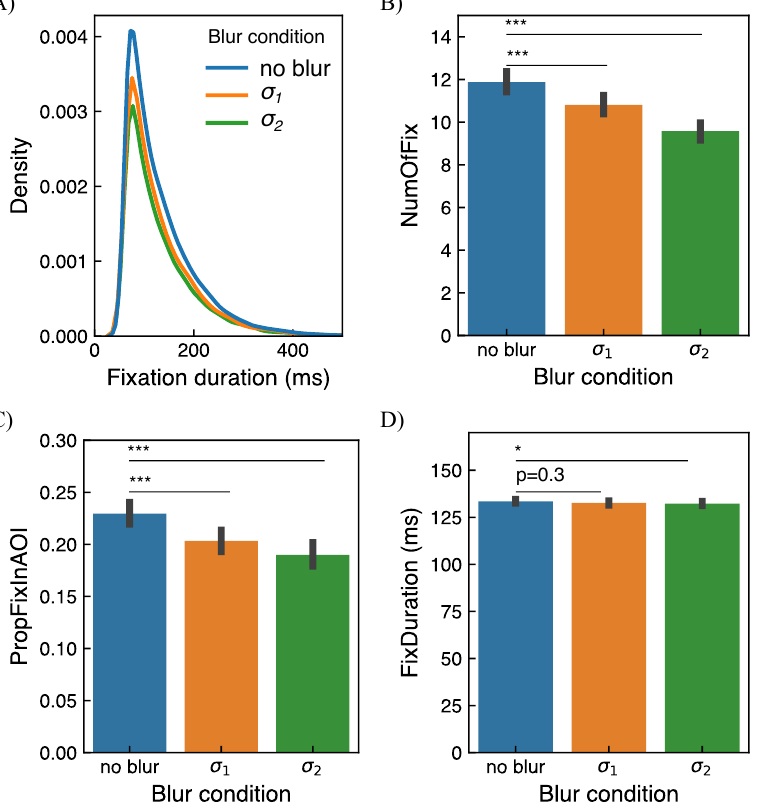
Figure 9. ( A ) A distribution of fixation duration as a kernel density estimate plot. Only fixations with duration up to 500ms are shown to better resolve differences between different blur conditions. The mean duration of fixation averaged over all subjects across all trials is 133ms ± 76ms. The plot represents all fixations computed for all subjects and all trials. Each curve is normalized to the number of observations such that the total area under all densities sums to 1. ( B ) An estimate of the number of fixations until the target was found in each blur condition. The bar plots represent data from 20 subjects considering only trials where the target was found. ( C ) An estimate of the proportion of fixations within the area of interest in each blur condition. The bar plots represent data from 20 subjects considering all trials. ( D ) An estimate of fixation duration in each blur condition. The bar plots represent data from 20 subjects considering all trials. The error bars show the standard error of the mean. The indicators of significant differences obtained from the linear mixed model analysis are *: p < 0.05, **: p < 0.005, ***: p < 0.001. For non-significant differences, the p -value is